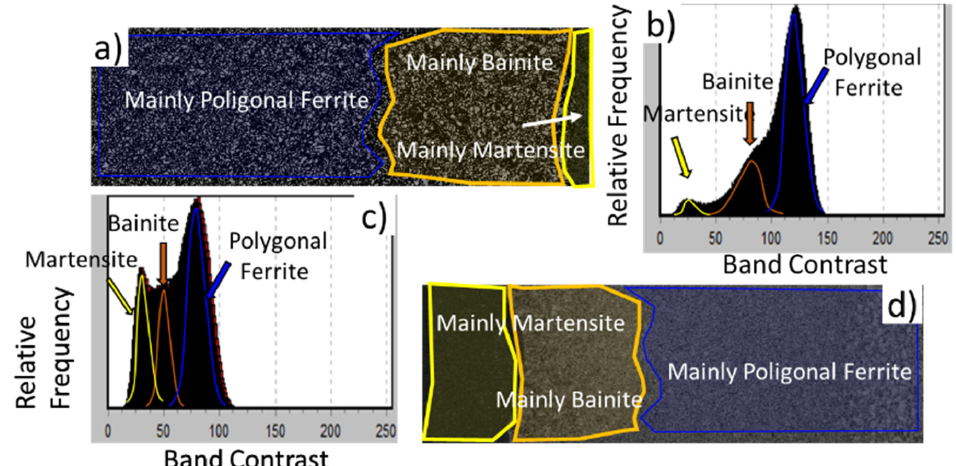
Figure 11. Detail of the microstructure in the FZ and HAZ regions analyzed in the EBSD-IPF maps. In ( a ) and ( b ), sample 9; in ( c ) and ( d ), sample 2.